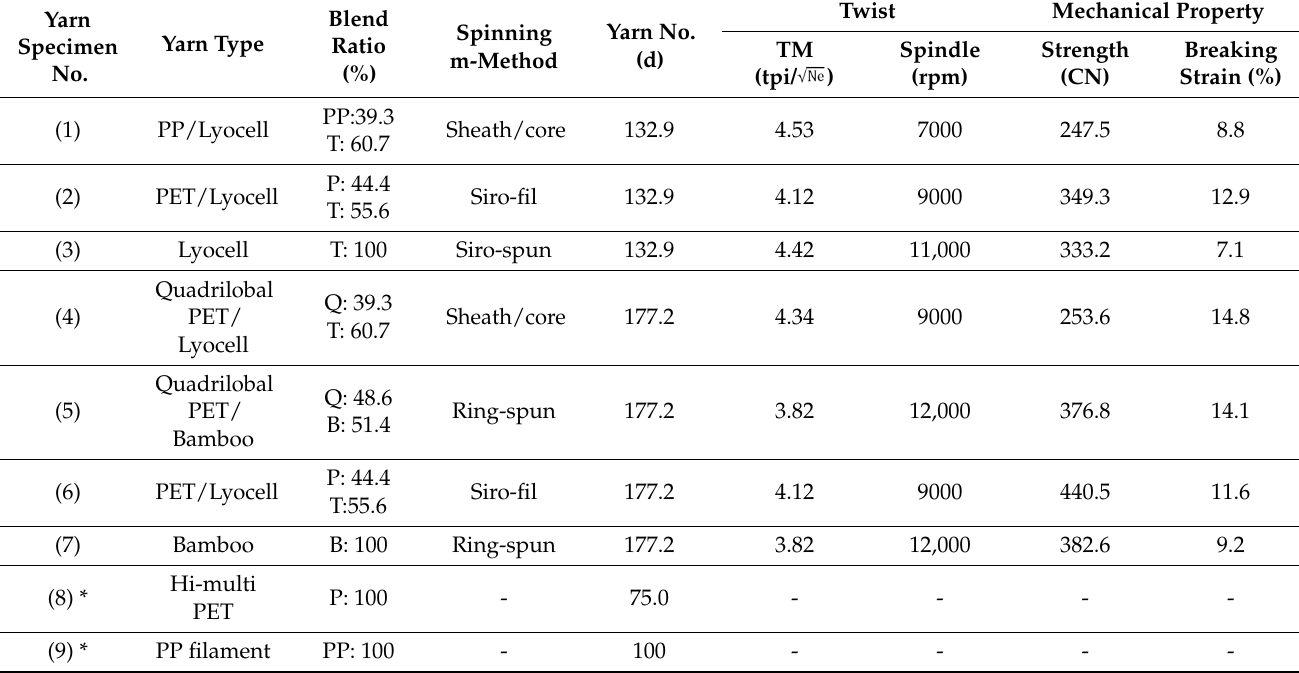
Table 1. Detailed specification of yarn specimens.